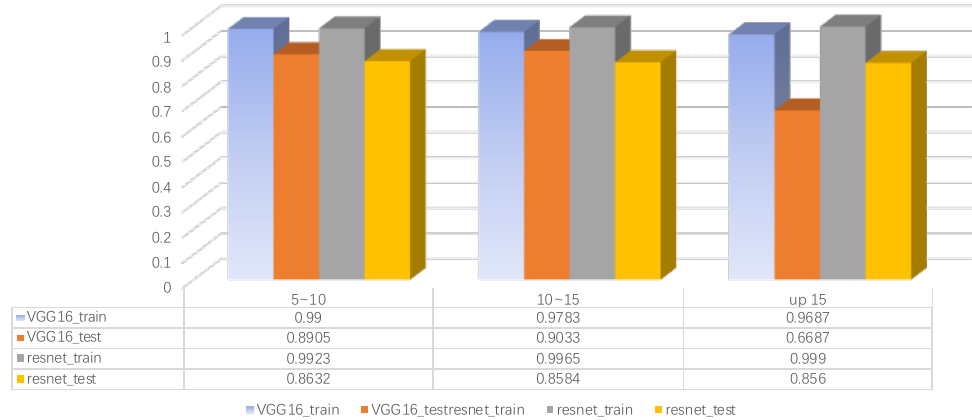
Figure 12. Comparison of classification accuracy between VGG16 and ResNet.